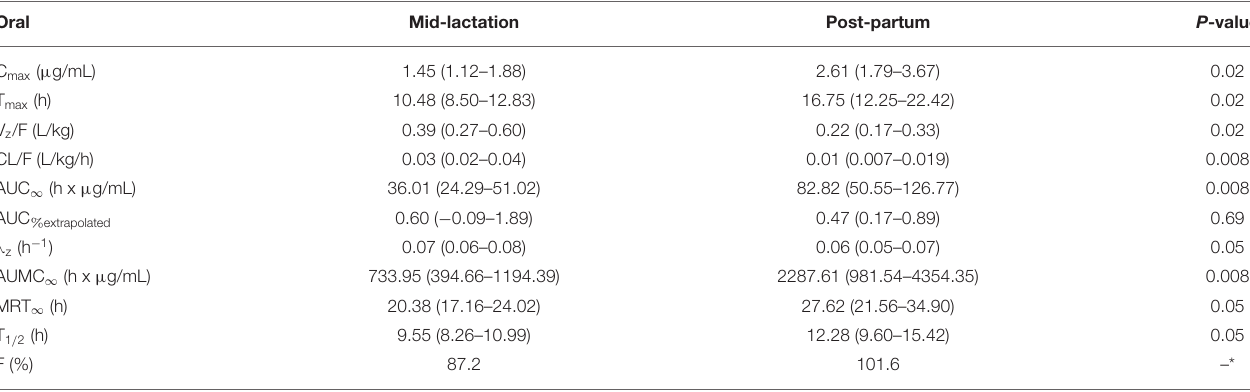
TABLE 5 | Plasma pharmacokinetic parameters for meloxicam from six post-partum cows matched to mid-lactation cows orally administered a single dose of meloxicam at 1.0